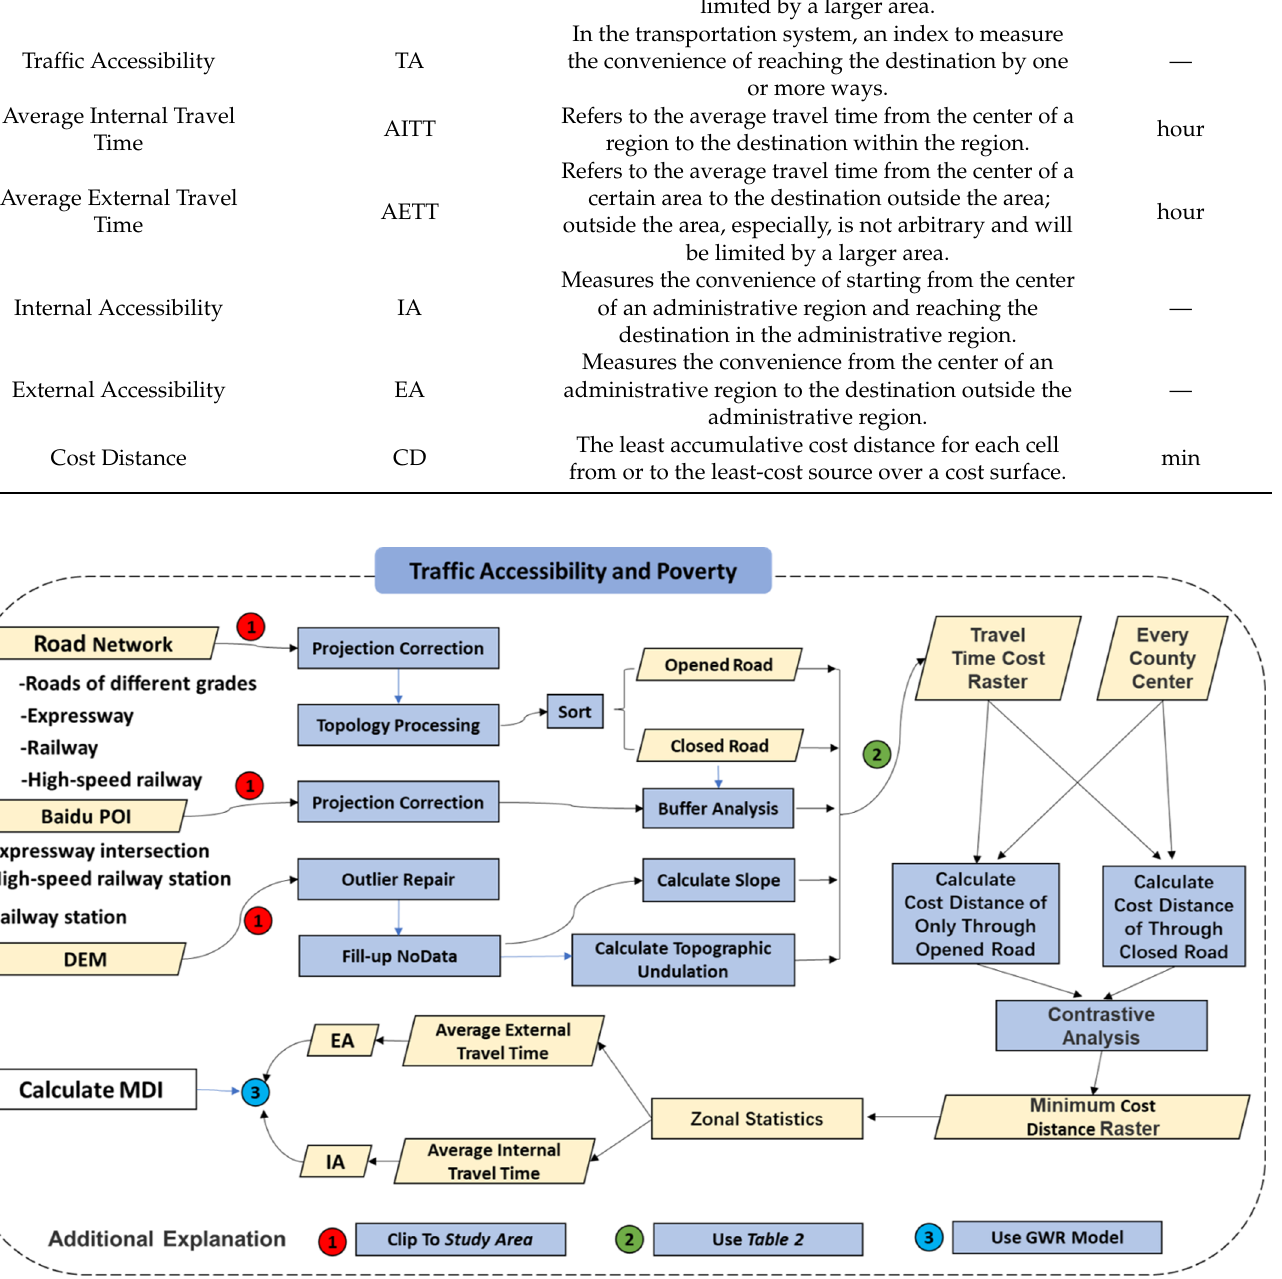
Figure 2. Flow chart of the research. Notes: cost distance: the least accumulative cost distance for each cell from or to the least-cost source over a cost surface. The cost distance is calculated by tools in GIS.